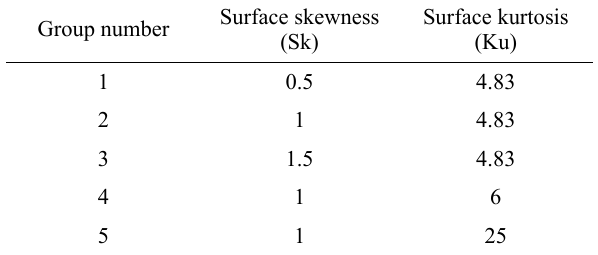
Table 1 Surface roughness parameters for flow factors calculation.